Question: Based on the figure, does the quantity rise or fall?
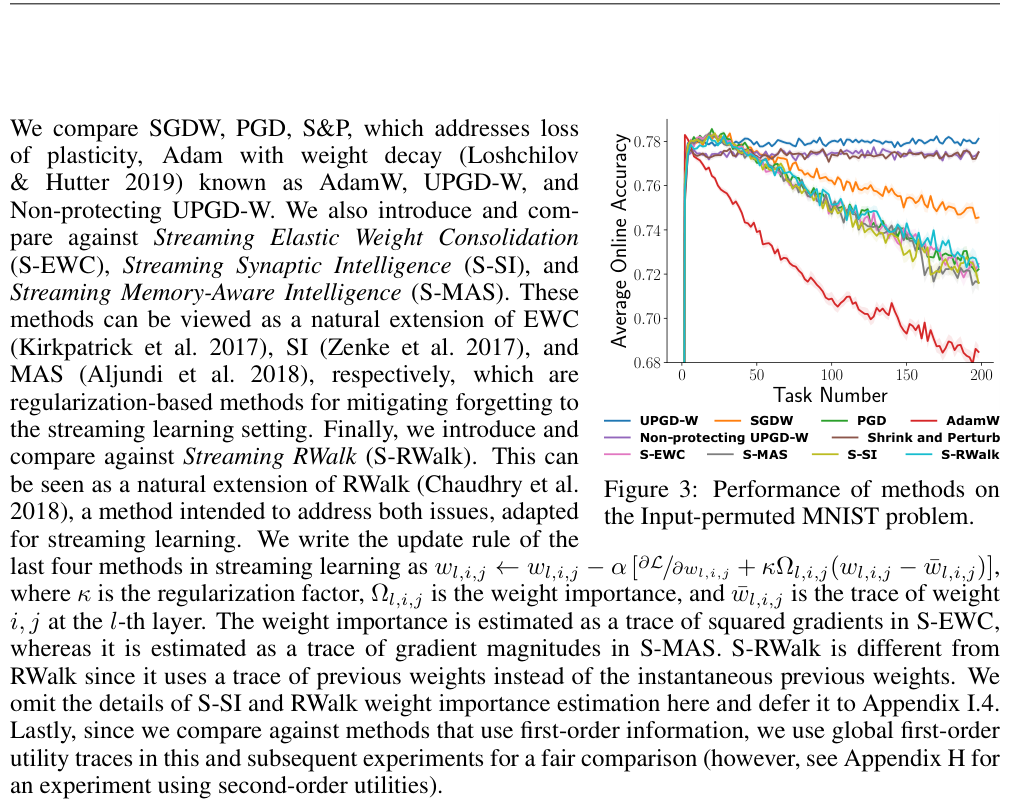
Answer: increasing